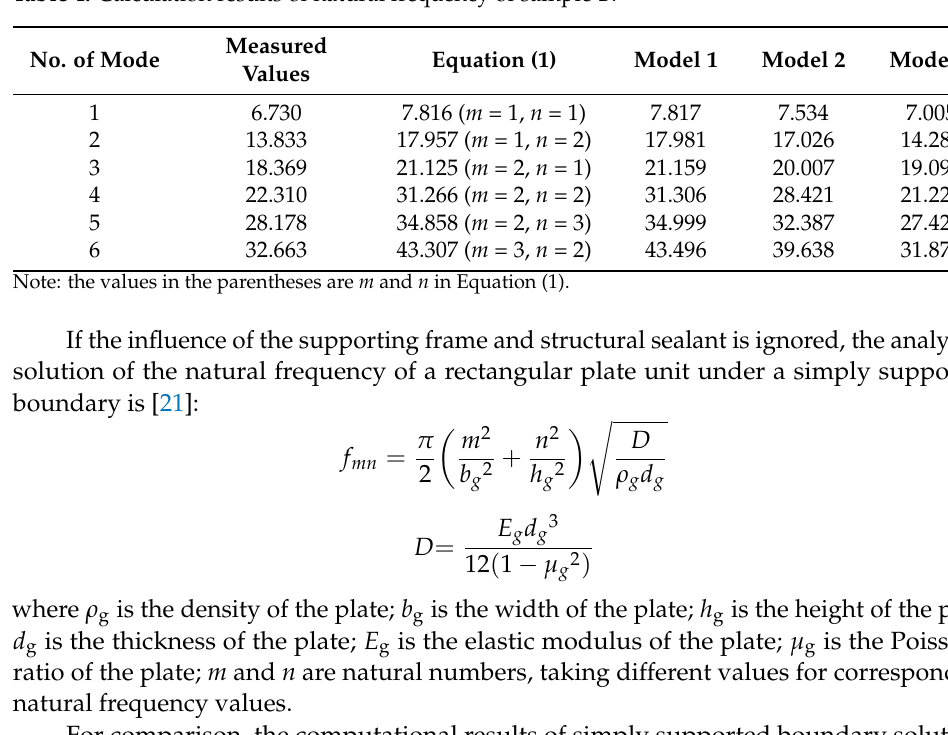
Table 4. Calculation results of natural frequency of sample